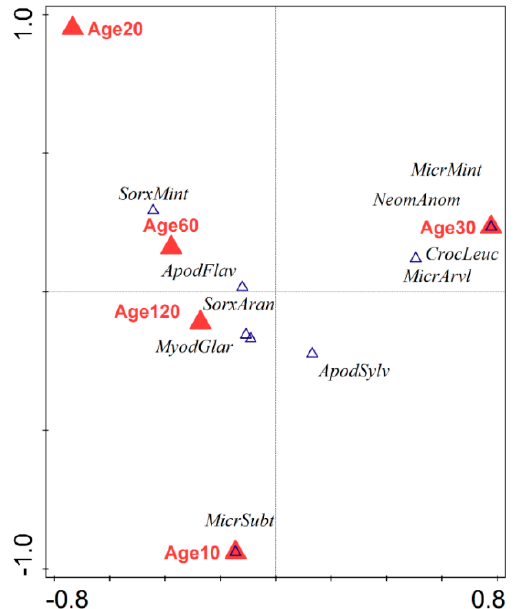
Figure 4. Partial canonical correspondence analysis biplot with the study month as a covariable showing the change in small mammal assemblages in relation to different forest successional stages. ApodFlav , Apodemus flavicollis ; ApodSylv , Apodemus sylvaticus ; MicrSubt , Microtus subterraneus ; MicrArvl , Microtus arvalis ; MicrMint , Micromys minutus ; MyodGlar , Clethrionomys glareolus ; CrocLeuc , Crocidura leucodon ; NeomAnom , Neomys anomalus ; SorxAran , Sorex araneus ; SorxMint , Sorex minutus .